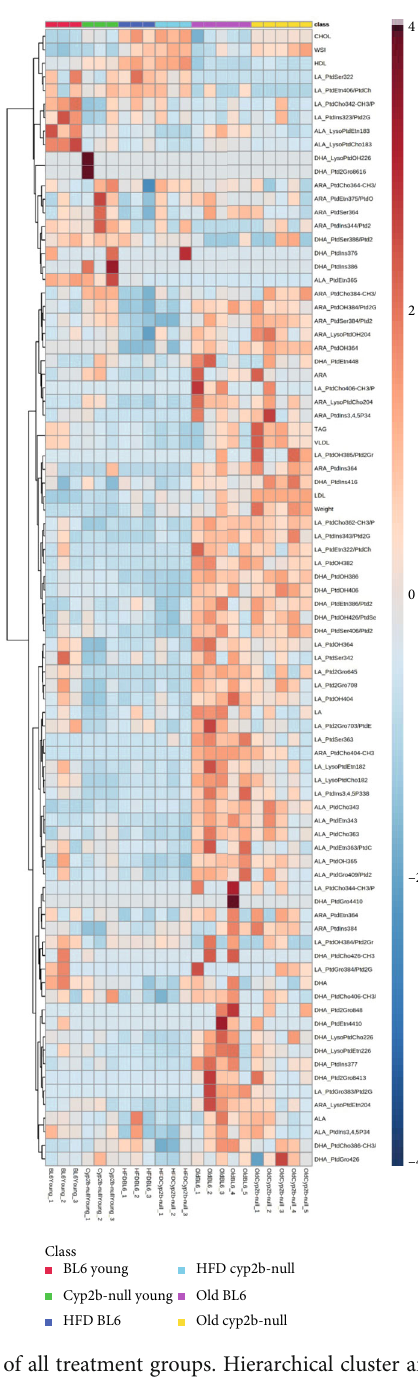
Figure 3: Heat map of phospholipid pro fi les of all treatment groups. Hierarchical cluster analysis heat map of all measured phospholipid species from ND-fed WT (BL6), ND-fed Cyp2b-null, HFD-fed WT, HFD-fed Cyp2b-null, old WT, and old Cyp2b-null mice. Seventy- seven lipid species were identi fi ed from liver samples of male mice by LC-MS/MS from arachidonic (ARA), linoleic (LA), α -linolenic (ALA), and docosahexaenoic acid